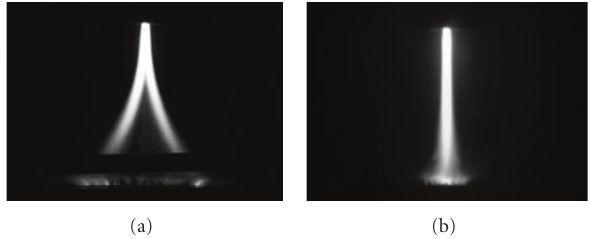
Figure 12: Arc driven by a rectangular AC magnetic field: front view (a) and side view